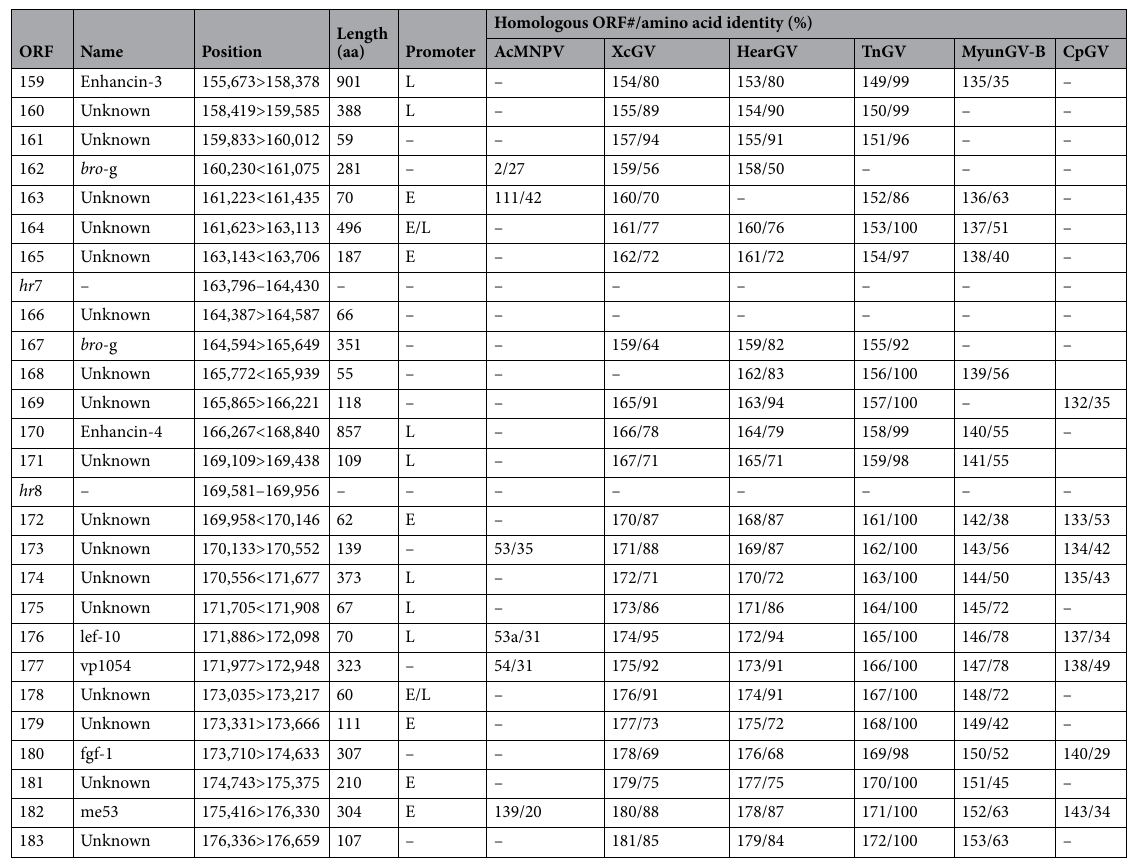
Table 1. MyunGV-A (PsunGV-H) open reading frames (ORFs) and homologous repeat regions ( hrs ). Putative MyunGV-A ORFs are listed in column 1 along with the gene homologues designated in column 2. Column 3 indicates ORF location and transcriptional direction on the MyunGV-A genome. Column 4 indicates the number of amino acids. Column 5 indicates the presences of early (E) and/or late (L) promoters located upstream of start codon of each ORF. E indicates a TATA sequence followed by a CAGT or CATT mRNA start site sequence 20–40 nucleotides downstream, with 180 bp upstream of the start codon. L indicates the presence of a (A/T/G)TAAG sequence. Column 6–11 list the homologous ORF and percent of amino acid identity from AcMNPV, XcGV, HearGV, TnGV, MyunGV-B and CpGV